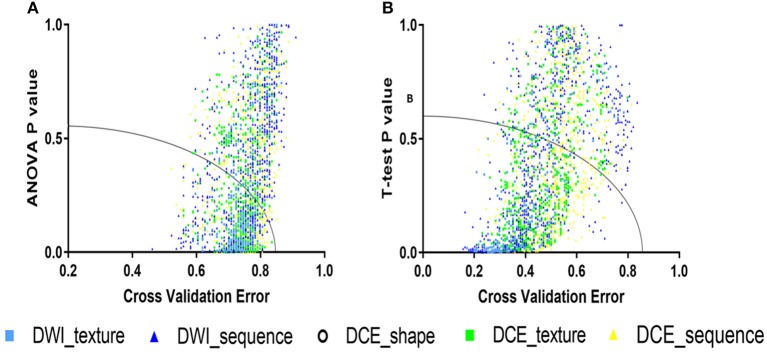
The accepted domains for coarse feature selection. (A) For the 4-IHC classification, the p-value for the analysis of variance (ANOVA) and cross-validation error were set to 0.6 and 0.85, respectively. (B) For the TN vs. non-TN cancers, the t-test p-value and cross-validation error were set to 0.54 and 0.76, respectively.